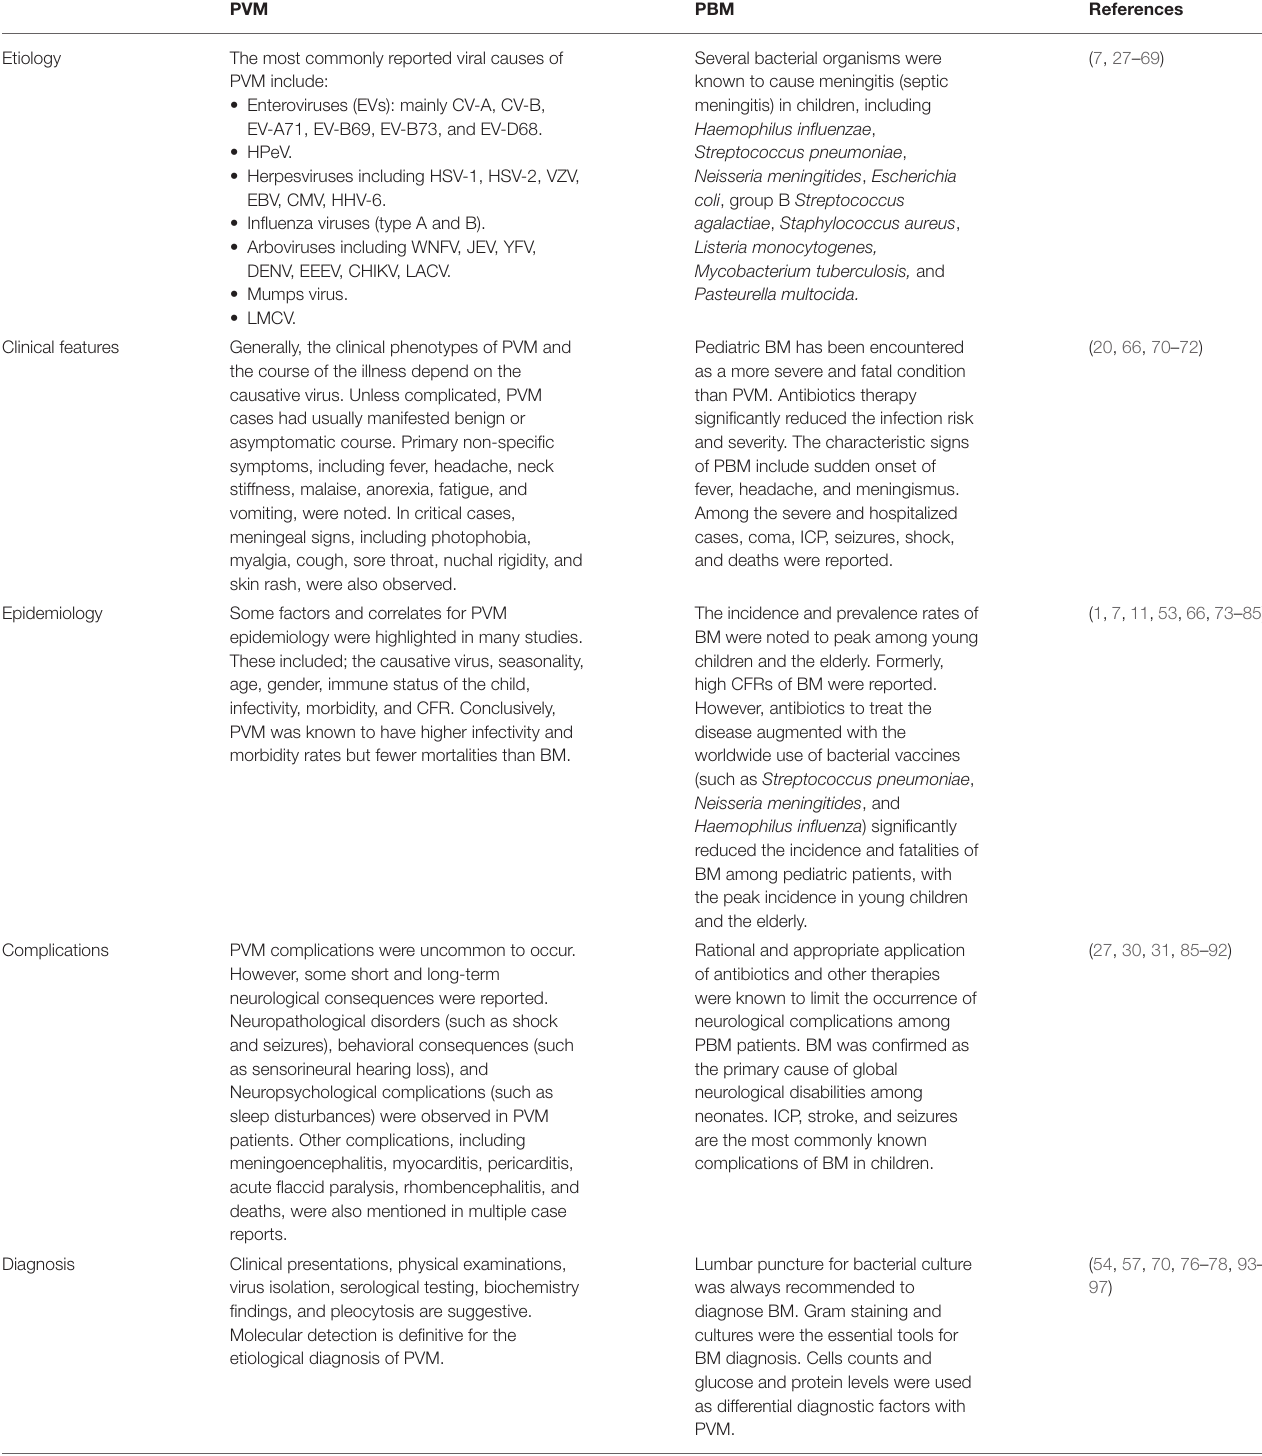
TABLE 1 | Distinctive etiological, clinical, epidemiological, complications, and diagnostic elements of pediatric viral and bacterial meningitis: Comparative presentation.